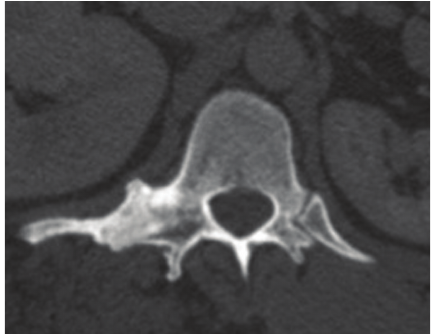
Figure 1: The right costovertebral joint space is fused. The T12 vertebra shows disproportionate asymmetric overgrowth which is characteristic for the Proteus